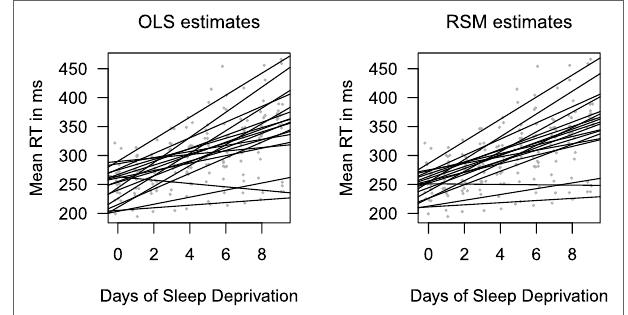
FIGURe 1 | Estimates of individuals’ regression lines. The response times (RT) are in milliseconds (ms). The left panel shows the results using OLS to calculate separate coefficients for each student. The right panel uses a RSM model where information of other students is used to shrink the coefficient estimates. The values for Days (light gray dots) have had a small random jitter added to them to make them easier to see.